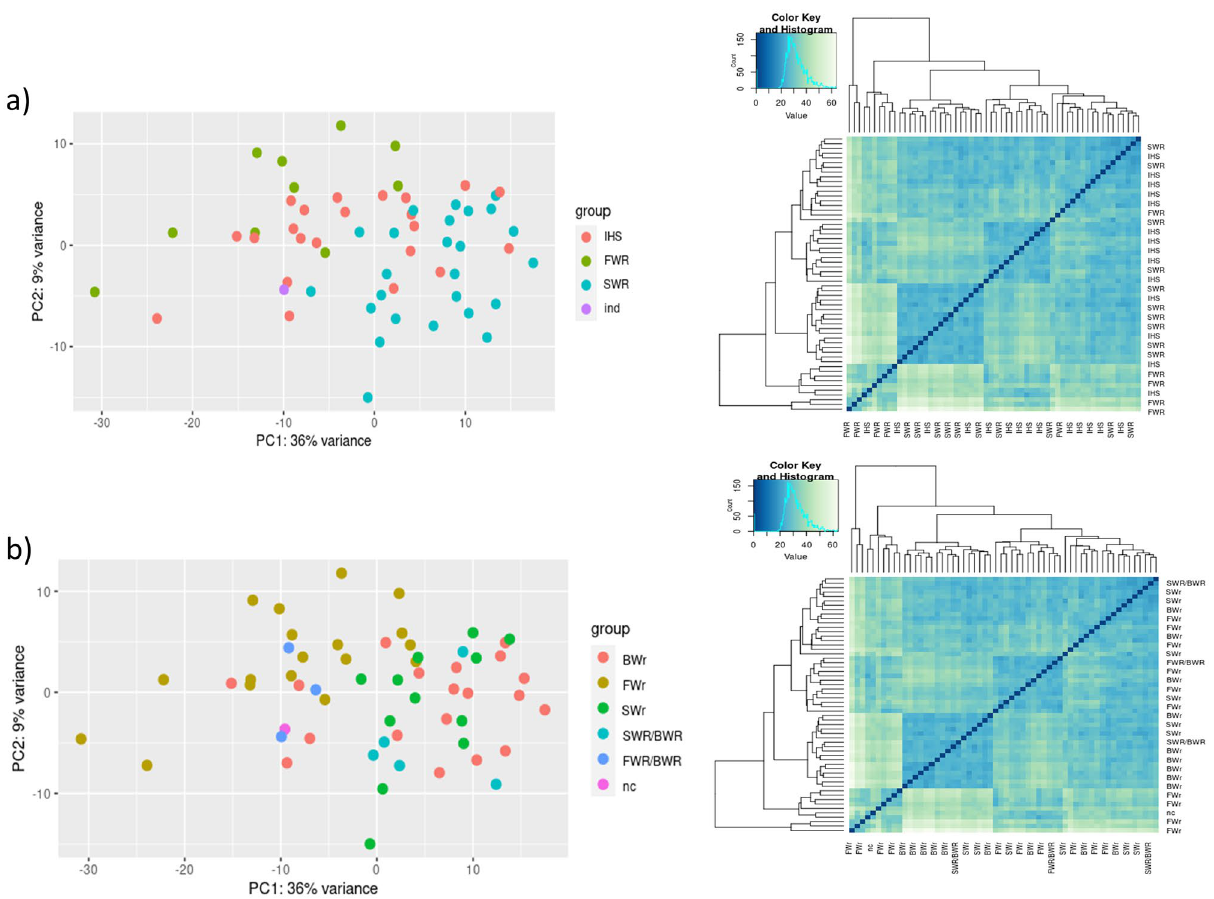
Figure 5. Principal component analysis (PCA) (left) and heatmap (right) for the otolith-based ( a ) and fatty acid ( b ) analyses based on the DE genes. For the heatmap, the intensity of the color is linked with the similarity of the sample in pairwise comparisons, where light color indicates higher divergence and darker color indicates higher similarity.